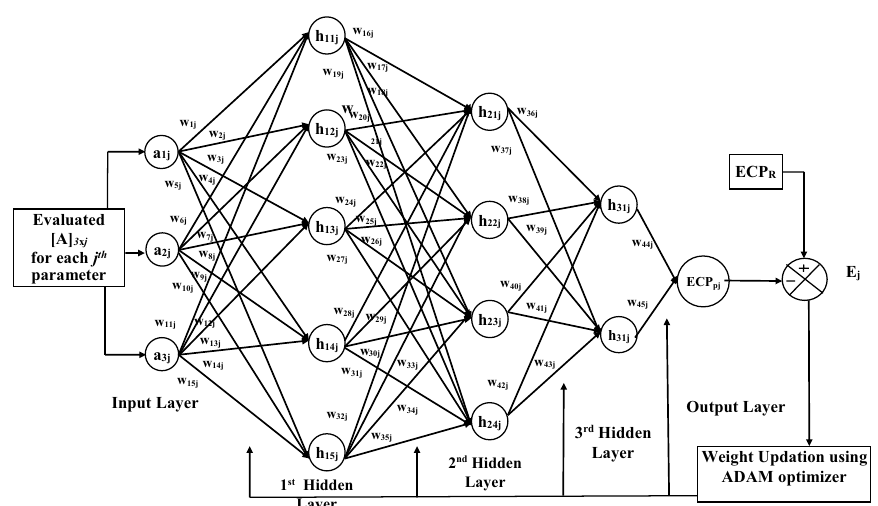
Fig. 5 Plant Model for ECPs